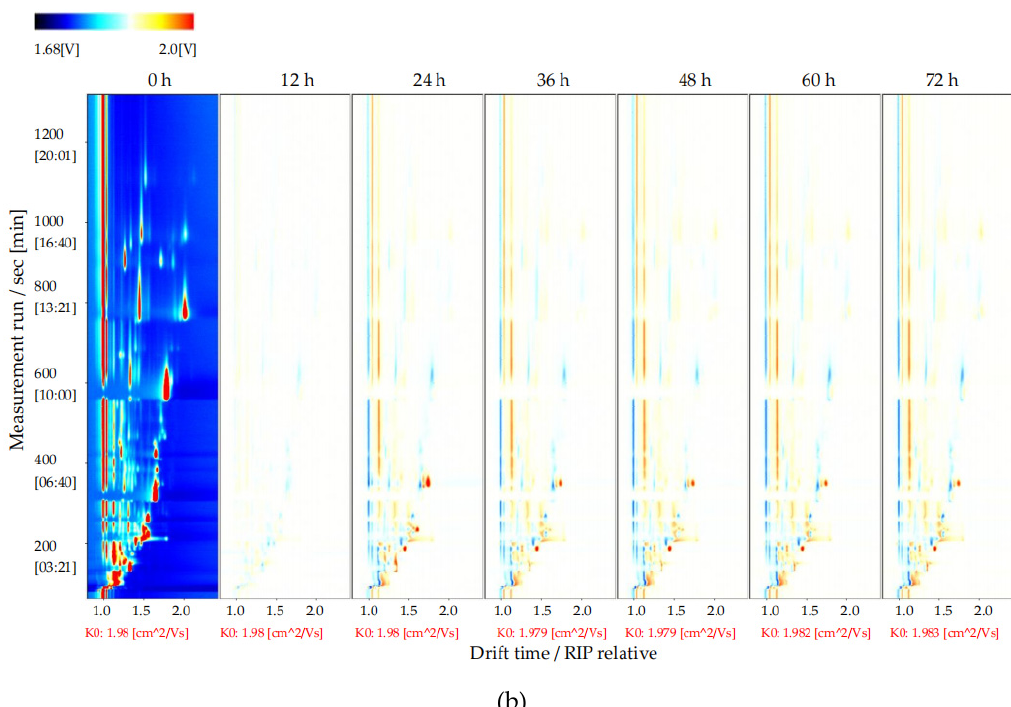
Figure 4. Results of GC − IMS two dimensional spectra for the volatile flavor compounds of the sea buckthorn juice fermented for 0 h, 12 h, 24 h, 36 h, 48 h, 60 h, 72 h. ( a ) Intuitive comparison; ( b ) differences comparison. the y − axis was the retention time of GC, the x − axis was the drift time of IMS. The red vertical line at 1.0 on the abscissa indicated the reaction ion peak (RIP). The spot on the right side of the RIP was characteristic peak signal of the flavor substances, which represented different volatile flavor substances in the sample.